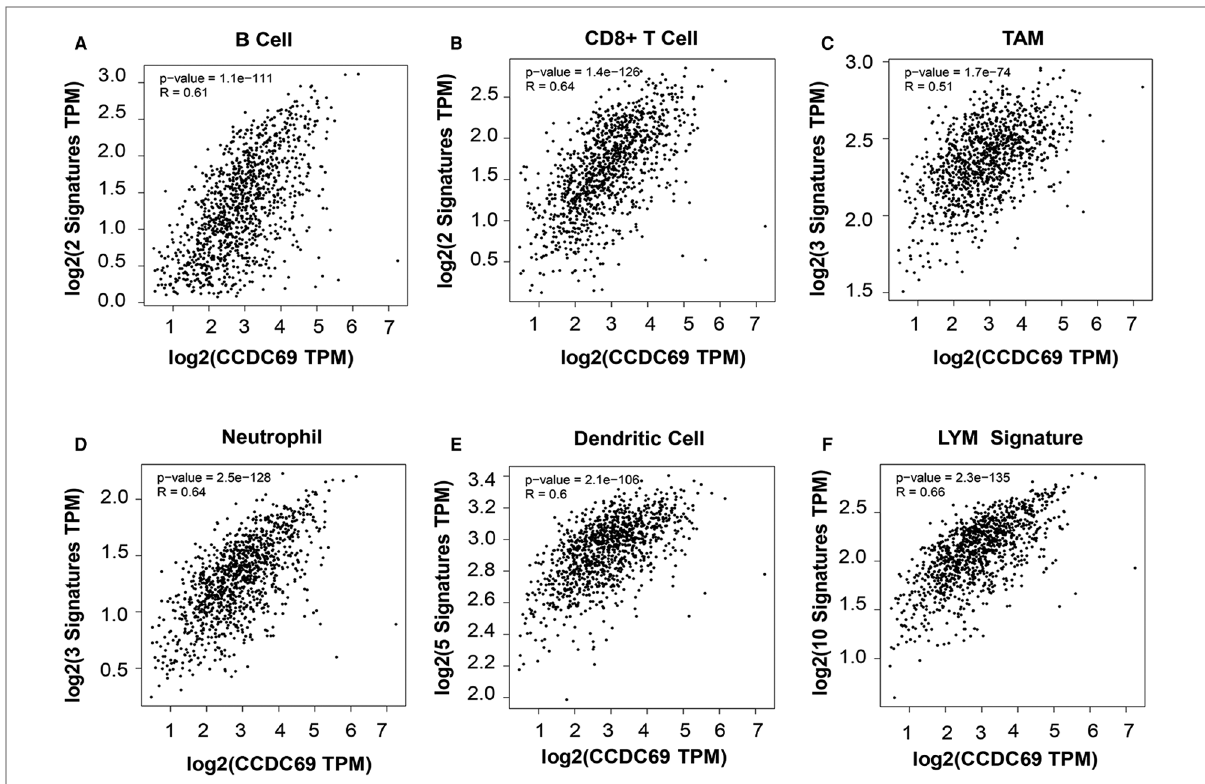
FIGURE 7 CDCC69 was positively correlated with TILs marker expression in BC. GEPIA2 was used to assess the association of CCDC69 expression levels with ( A ) CD8+ T cells, ( B ) B cells, ( C ) TAM, ( D ) neutrophils, ( E ) DC and ( F ) LYM metagenetic characteristics.